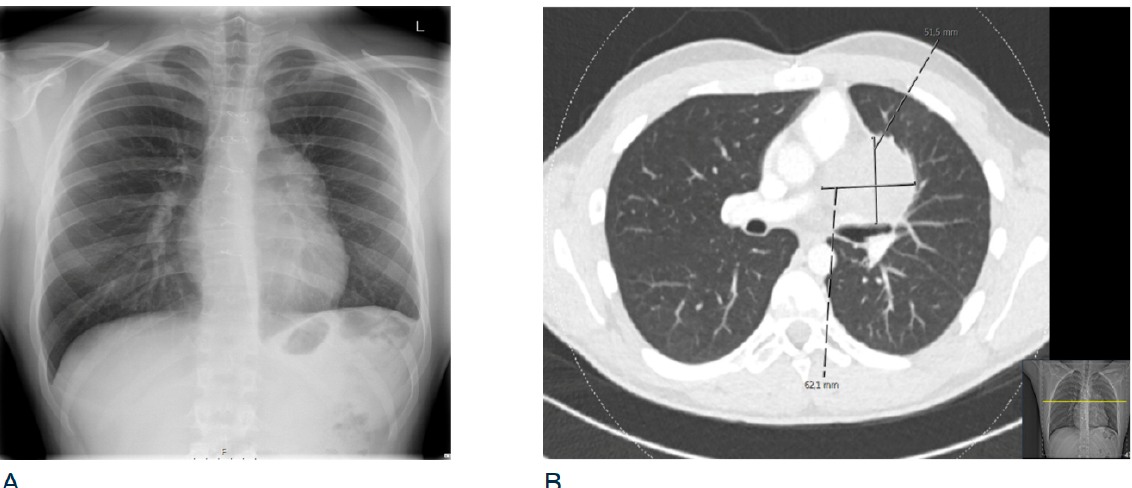
Figure 2. ( A ) Follow-up chest X-ray showing a broadened aorto-pulmonary window a year and a half after resection of malignant mediastinal GCT; ( B ) CT scan confirming recurrent mass in the anterior mediastinum.